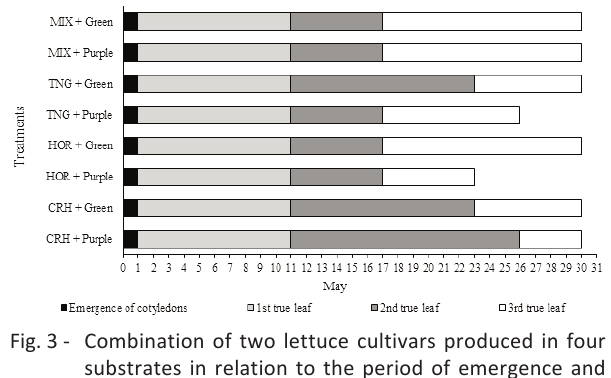
Fig. 3 - Combination of two lettuce cultivars produced in four substrates in relation to the period of emergence and expansion of the first true leaves. CRH= Carbonized rice hull; HOR= Horta 2®; TNG= TN Gold®; MIX= mixture; Purple=Mimosa Roxa Salad Bowl cultivar; Green= Mônica SF 31 cultivar.